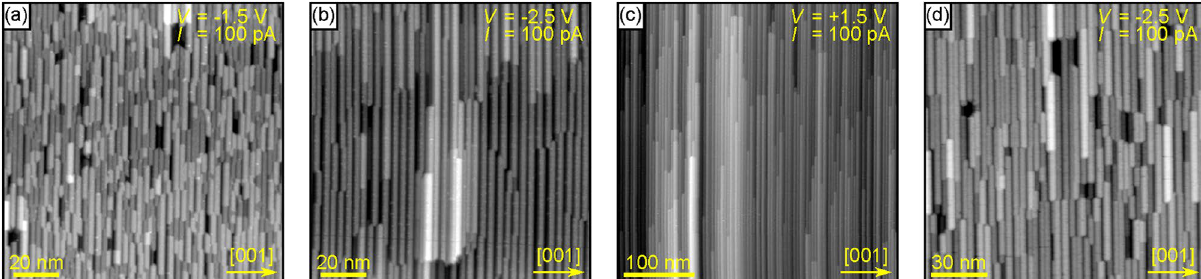
Figure 3. STM images of various Au silicide nanowire preparations. ( a ) About 1.0 ML Au deposited at room temperature followed by annealing at 400 ◦ C for 2 min . ( b ) The sample shown in ( a ) additionally annealed at 600 ◦ C for 2 min . ( c ) About 1.0 ML Au deposited on a sample heated to 500 ◦ C . ( d ) About 1.5 ML Au deposited at room temperature followed by annealing at 600 ◦ C for 2 min